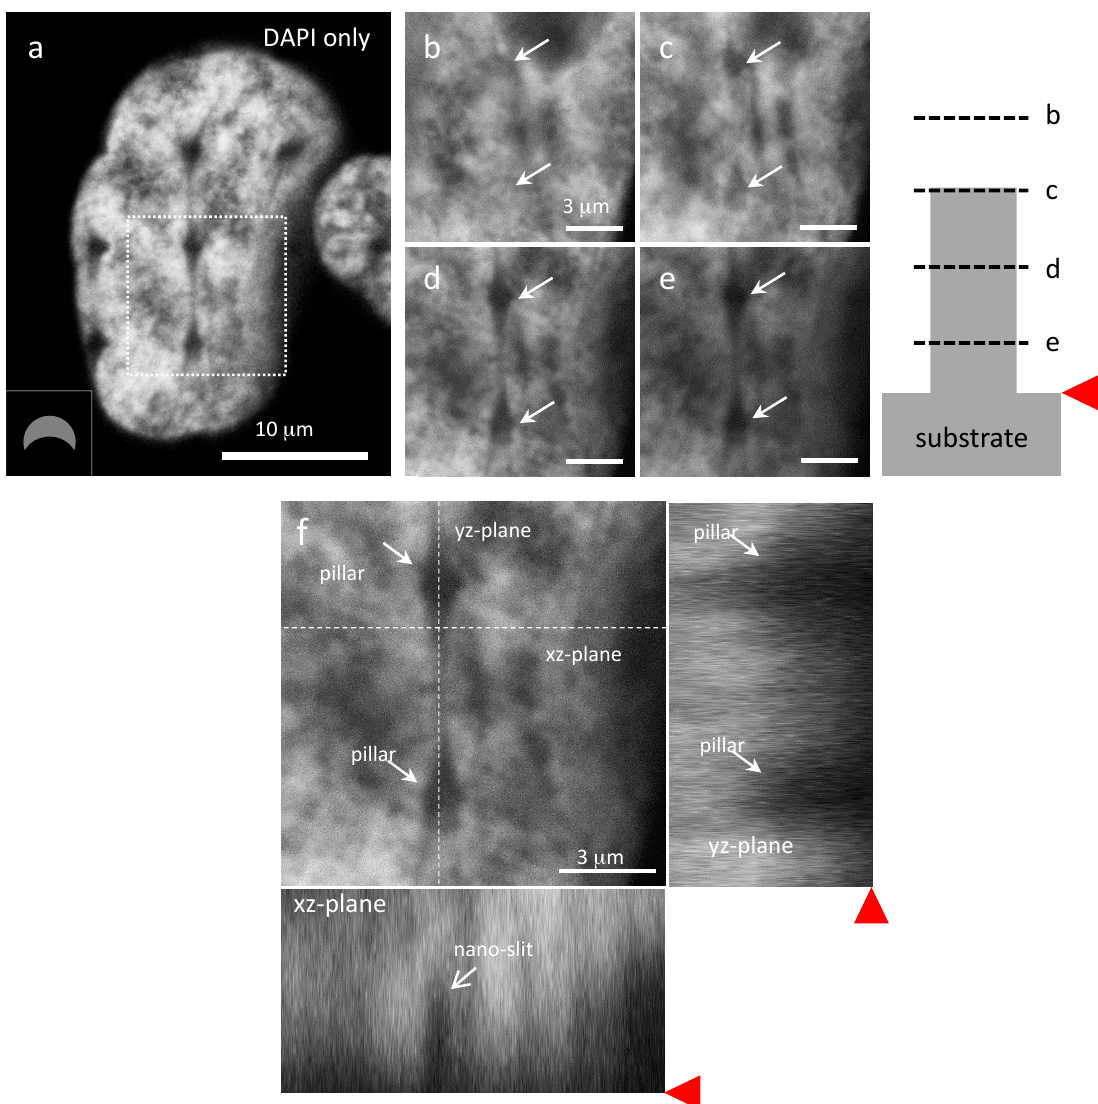
Figure 5. ( a ) DAPI only micrograph revealing fine line structures in cells incubated on small C-shaped pillars. High magnification images of a representative nucleus surrounding two small C-shaped pillars imaged in various focal planes are shown in ( b – e ). The corresponding focal plane locations are illustrated in the schematic drawing. Orthogonal views of this nucleus are shown in ( f ) revealing two pillars and a nano-slit. Red triangle pointers indicate substrate surface locations.